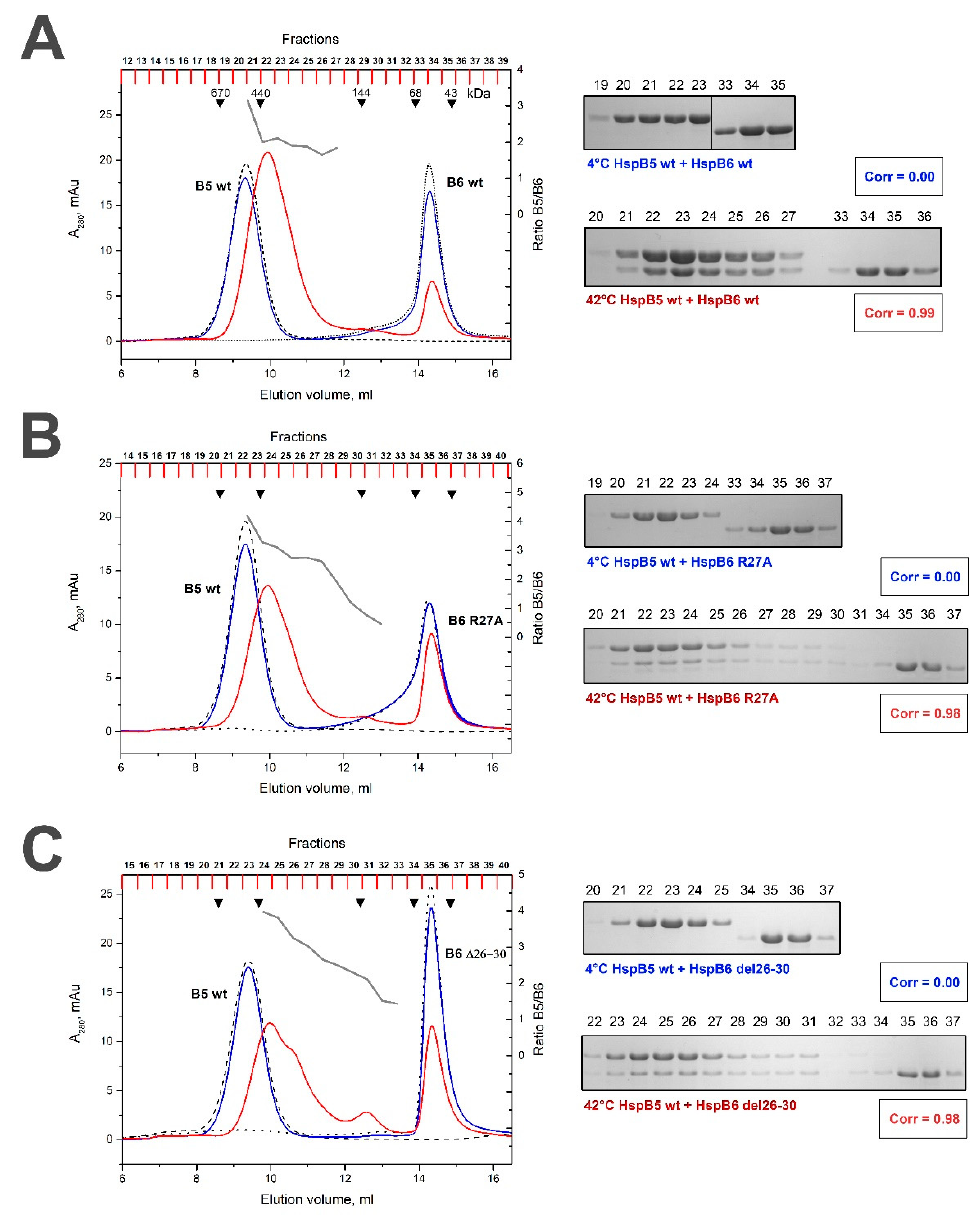
Figure 6. Size-exclusion chromatography of the WT HspB6 ( A ), its R / A ( B ) and ∆ ( C ) mutants and their mixtures with the WT HspB5. The elution profiles of isolated HspB6 or its mutants are shown as a black dotted line, that of isolated WT HspB5 by a black dashed line. The elution profile of the mixture of HspB6 species and WT HspB5 preincubated at low temperature is shown as a solid blue line and that of the corresponding mixture preincubated at elevated temperature is shown as a solid red line. The molar ratio HspB5 / HspB6 (grey solid line) in the corresponding fractions obtained after the chromatography of preheated sample is indicated on the right ordinate. Protein compositions of fractions obtained after chromatography of HspB5 / HspB6 mixture preincubated at low (labeled blue) or high (labeled red) temperature are presented on inserts. The correlation coe ffi cient (Corr) is indicated under each electropherogram. The numbers above tracks correspond to the fractions number. Apparent molecular weights are indicated by